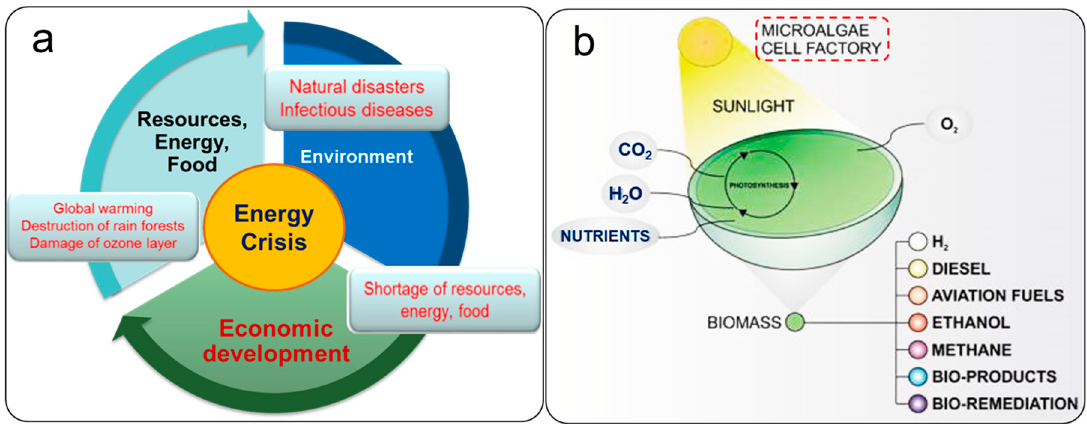
Figure 1. Resources, food demand, economic development and environmental pollution in the world as the main reasons for energy concerns ( a ). The use of microalgae cells as a factory for the production of various biofuels and value-added products ( b ), adapted from [12].